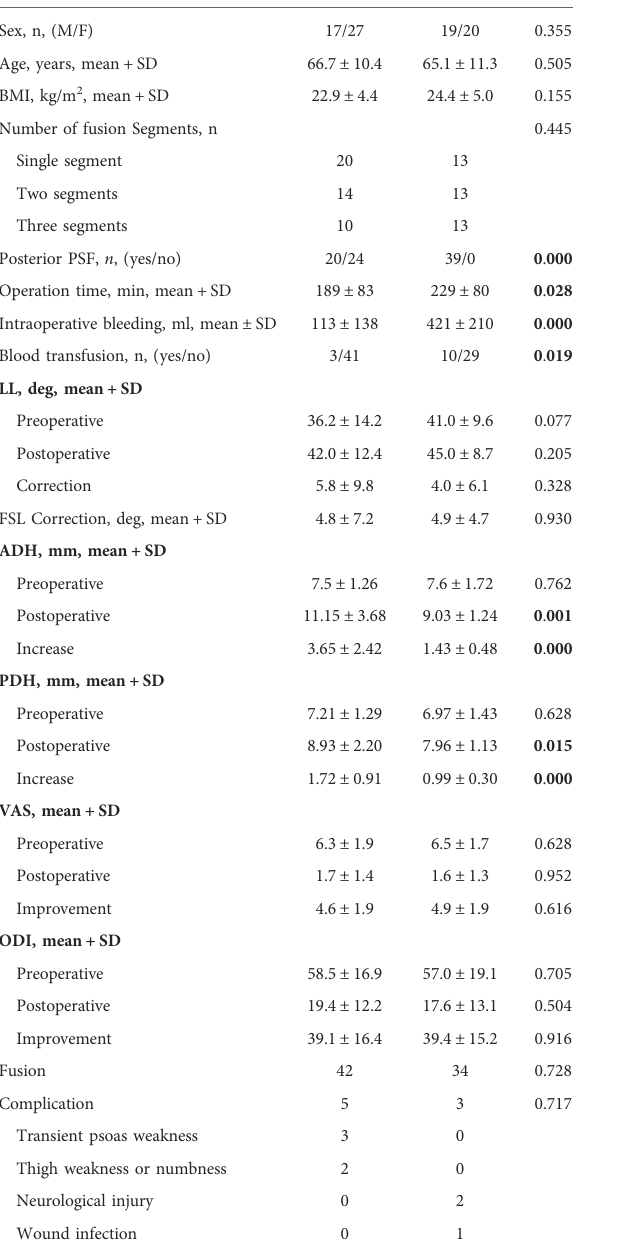
TABLE 1 The comparison of general basic data of OLIF and MIS-TLIF. Parameters OLIF